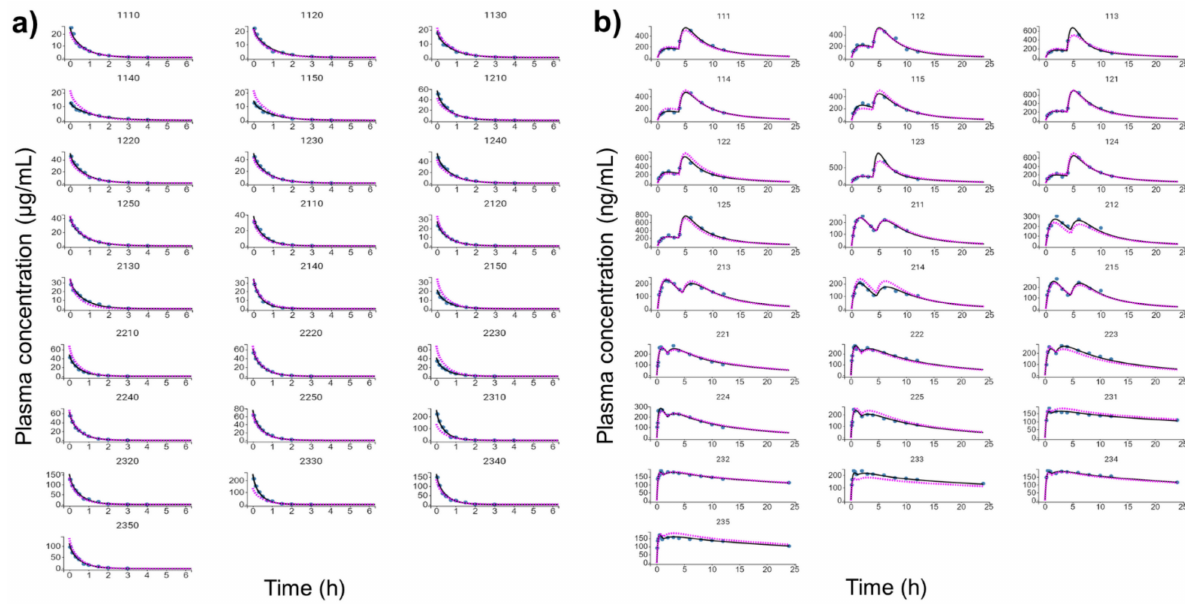
Figure 4. Individual and population-fitted plasma profiles of rutin and quercetin in rats using the nonlinear mixed-effect modeling approach ( n = 5 for each dose). ( a ) Plasma profiles of rutin after intravenous administration of pure compound (RU) or hydroalcoholic extract from Physalis peruviana (HEE). 1110–1150: RU 1.45 mg/kg; 1210–1250: RU 2.9 mg/kg; 2110–2150: HEE 250 mg/kg (equivalent to 3.7 mg/kg of RU); 2210–2250: HEE 500 mg/kg (equivalent 7.4 mg/kg of RU); 2310–2350: HEE 1000 mg/kg (equivalent to 14.8 mg/kg of RU). ( b ) Plasma profiles of quercetin (representing the conjugates quercetin-3- O -glucuronide and quercetin-3- O -sulfate) after oral administration of RU or HEE. 111–115: RU 75 mg/kg; 121–125: RU 100 mg/kg; 211–215: HEE 500 mg/kg (equivalent to 7.4 mg/kg of RU); 221–225: HEE 750 mg/kg (equivalent to 11.1 mg/kg of RU); 231–235: HEE 1000 mg/kg (equivalent to 14.8 mg/kg of RU). Blue dots: observations; solid black line: individual pharmacokinetics model predictions; dashed violet line: population model